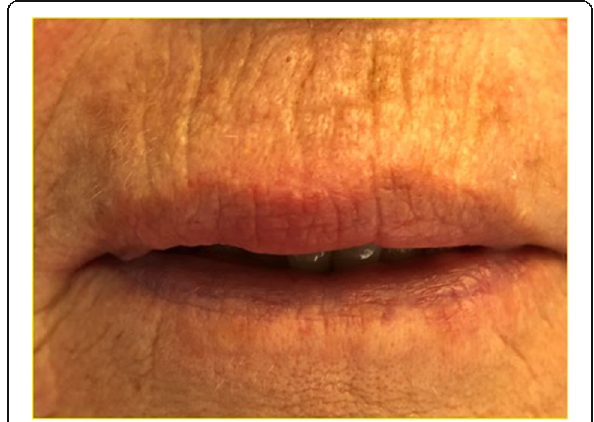
Fig. 5 Clinical result achieved after photobiomodulation with LLLT which remained stable over the next 2